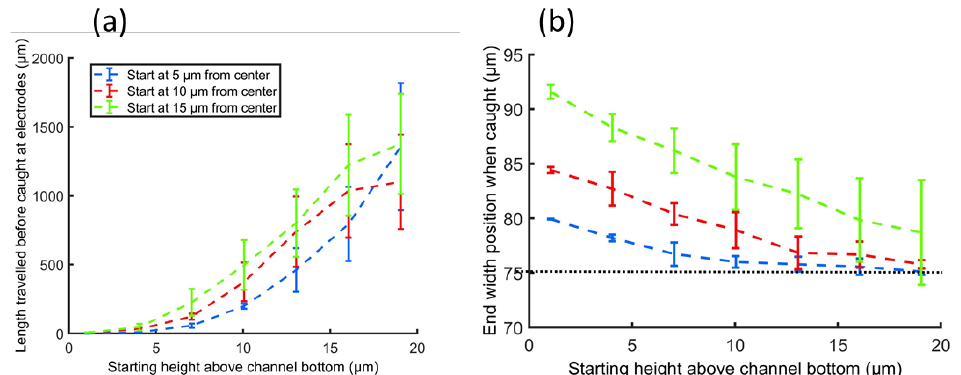
Figure 7. ( a ) The required channel length to catch particles on the electrode plane as a function of